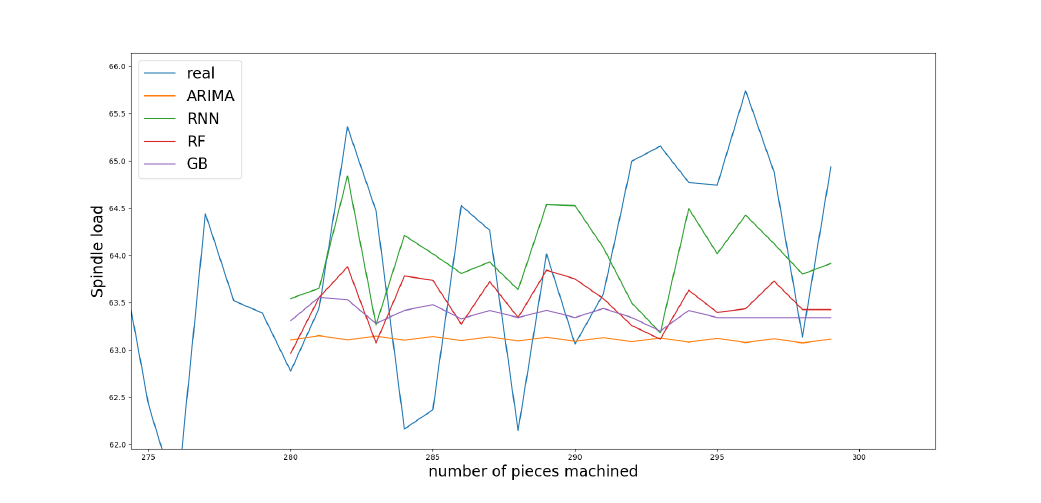
Figure 6. Prediction for the mean series of each